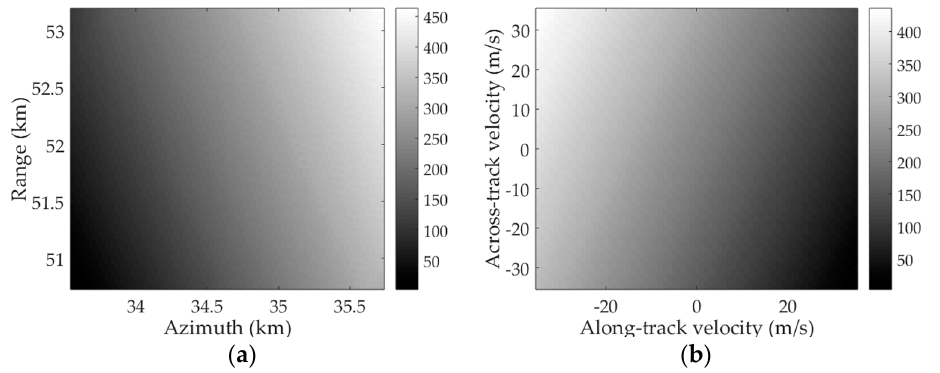
→ a = ( 50,50,50 ) m/s 2 :